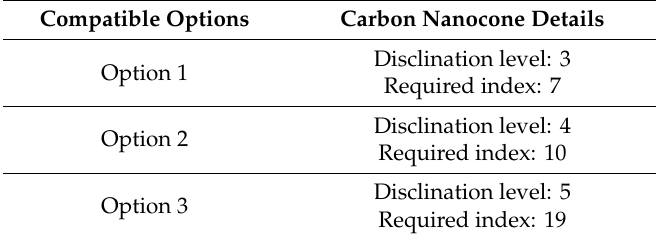
Table 4. List of compatible carbon nanocones with (9,9) or (18,0) carbon nanotubes.